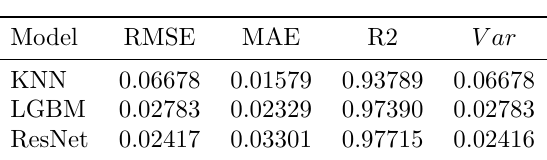
Table 7. Performance of different models on test set with